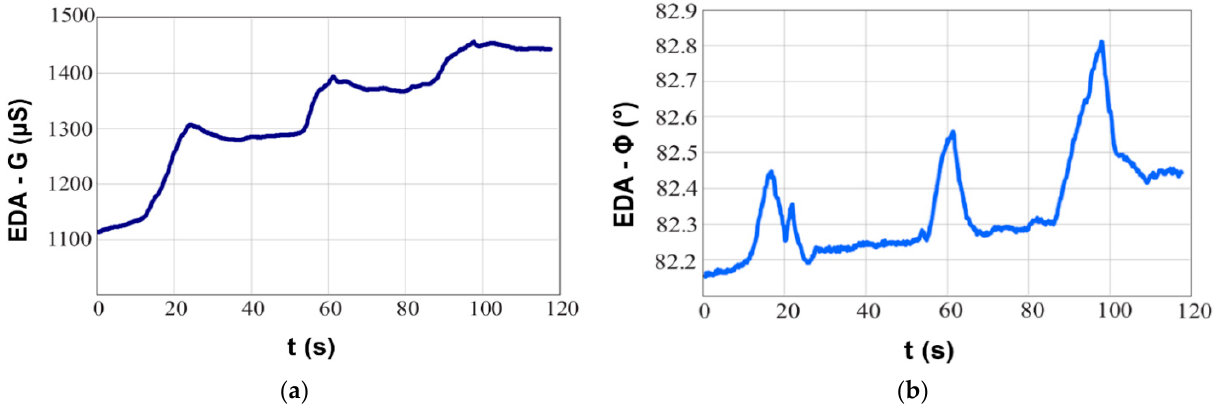
Figure 4. EDA—complex impedance measured using a 10 kHz harmonic input signal: ( a ) conductivity ( b ) phase.